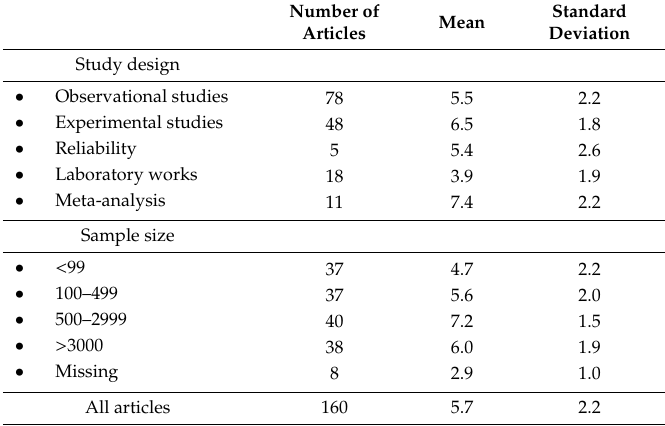
Table 3. Mean and standard deviation of the data analysis reporting score from 160 articles by study design and sample size.